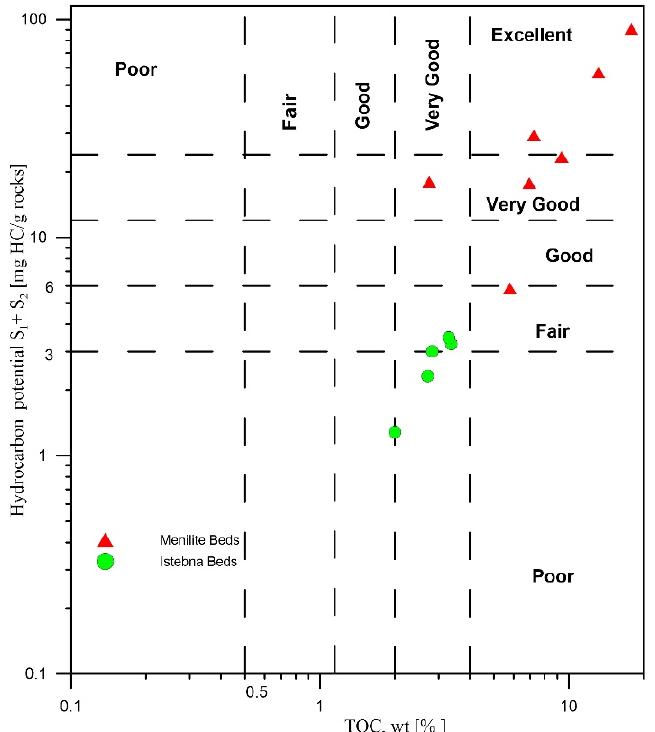
Figure 2. Variation in generation potential of Menilite and Istebna Beds. Boundaries according to Peters and Cassa